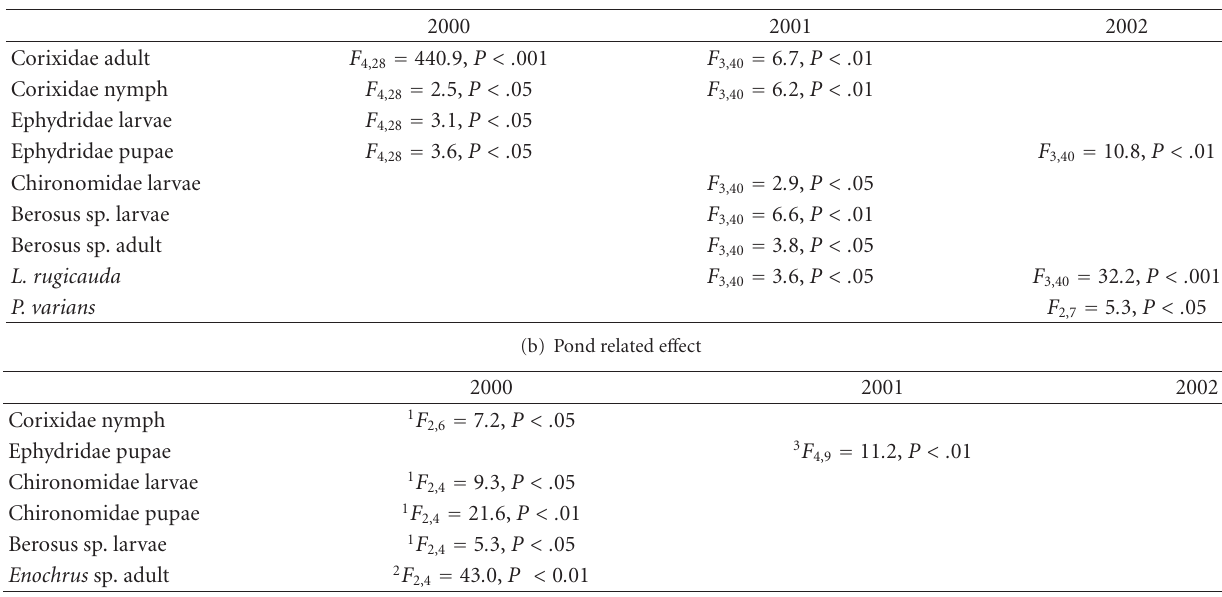
Table 3: Significant di ff erences between saltpans and between ponds for relative abundances of macroinvertebrate groups (one-way ANOVA).